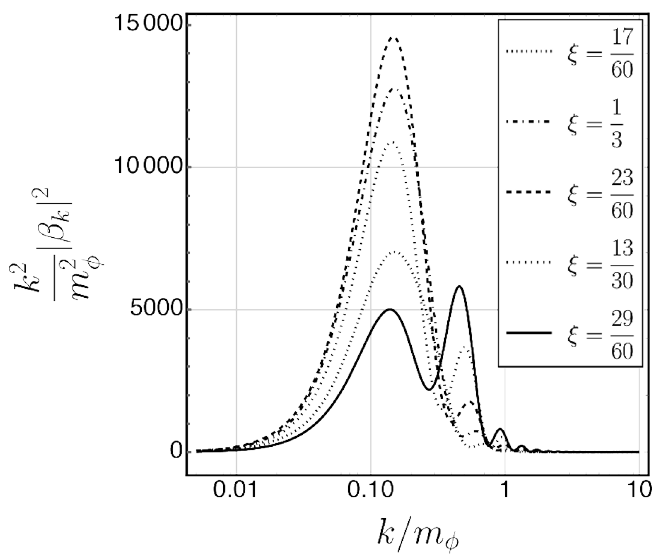
Figure 2 . Representative spectral particle production in the regime m 2 (cid:28) ( (cid:24) (cid:0) 1 = 6) j min( R osc ) j . The speci(cid:12)c (cid:12)eld mass we are showing is m = 1 : 2 (cid:2) 10 6 GeV. The di(cid:11)erent ampli(cid:12)ed bands appear because each oscillation of the Ricci scalar will excite di(cid:11)erent modes of the (cid:12)eld due to the time dependence of the equations of motion.